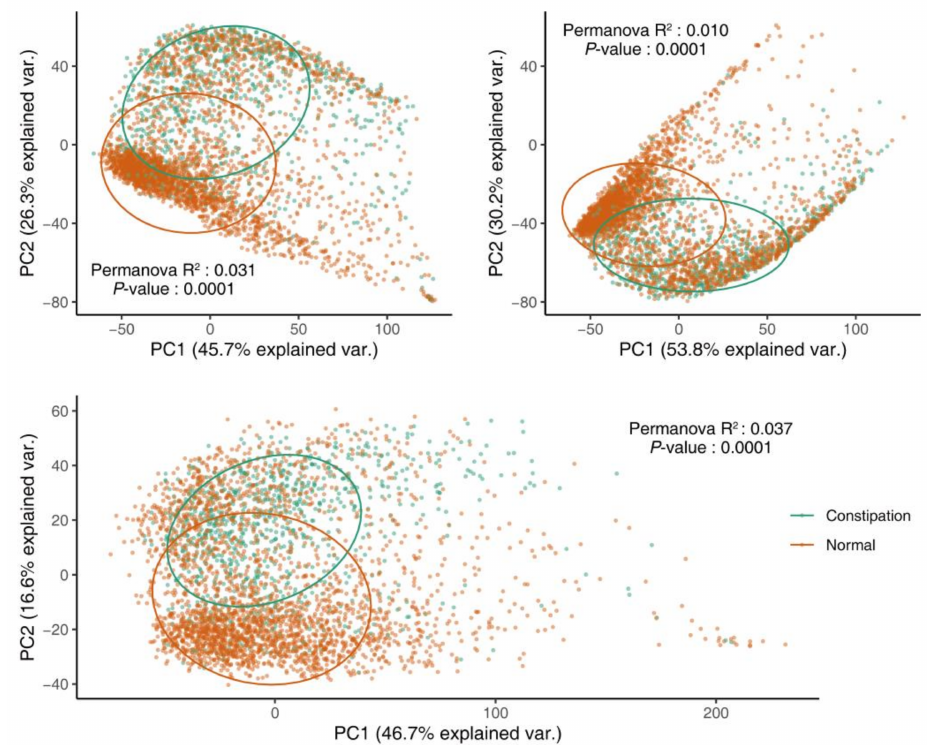
Figure 3. Principal component analysis based on Bray-Curtis, unweighted Unifrac, and weighted Unifrac distance matrices showed significant difference in the β -diversity of the gut microbiome between patients with constipation and healthy